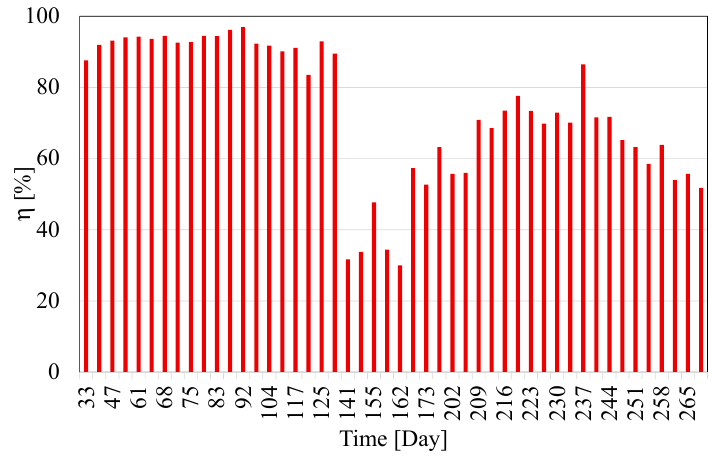
Figure 4. Aromatic hydrocarbons removal efficiency throughout experiments.